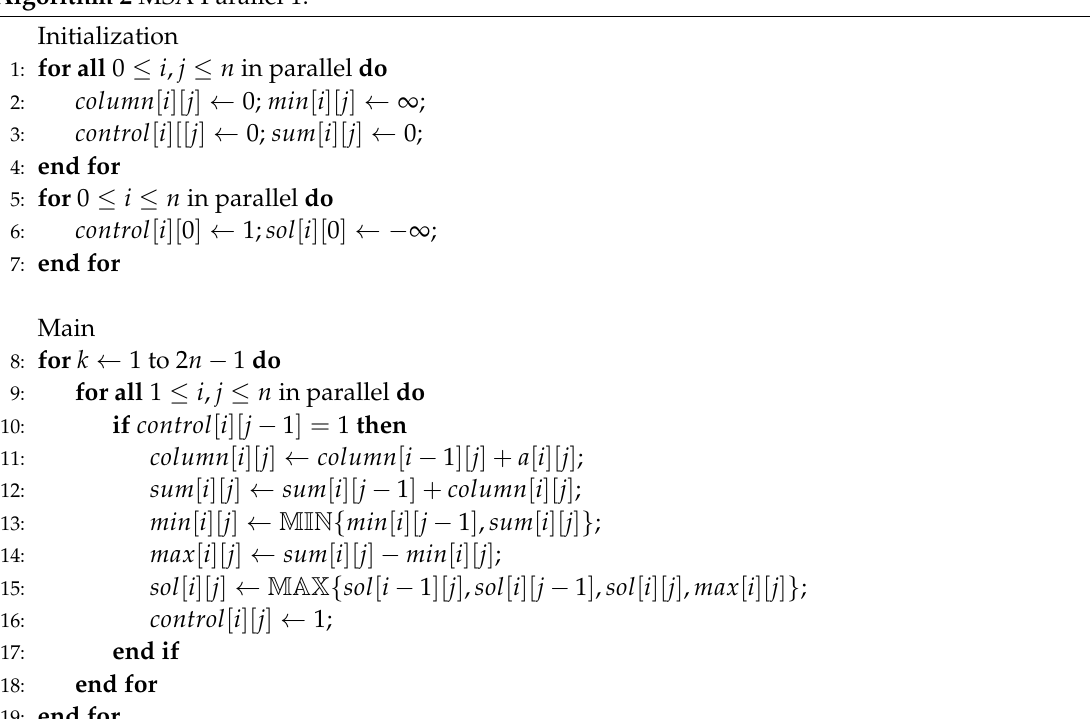
Figure 4. Illustration for Algorithm 2: The coverage of cell ( i , j ) at step k . Algorithm 2 MSA Parallel